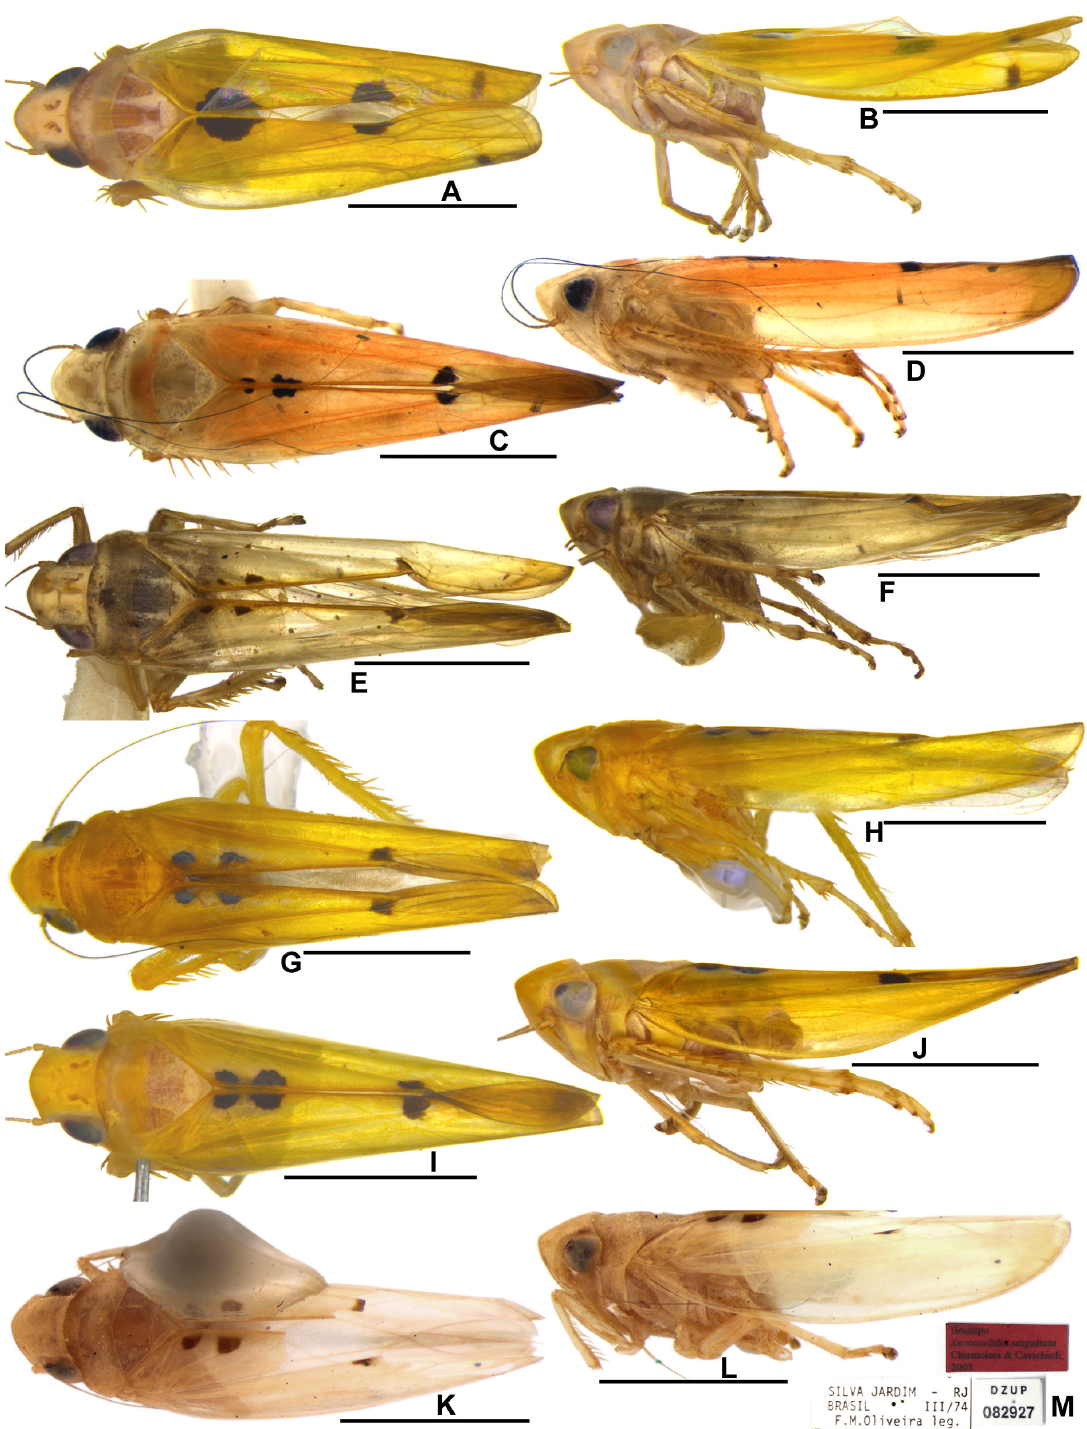
Fig. 12. Habitus of type specimens, dorsal and lateral view, respectively. A – B . Takiyaella anomala gen. et sp. nov., ♂, holotype (DZRJ-AUCH #238). C – D . T . cavichiolii gen. et sp. nov., ♂, holotype